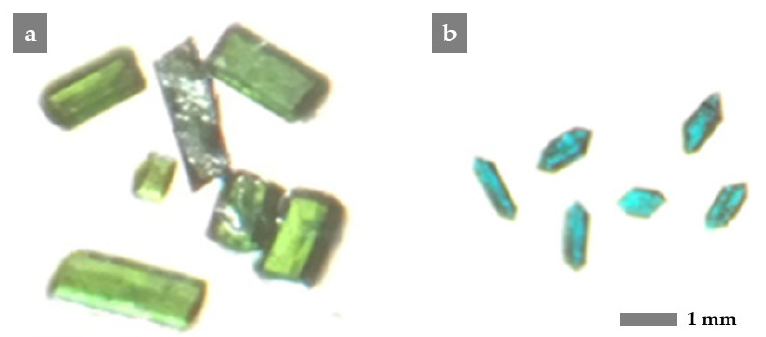
Figure 1. The obtained single crystal photos for 1 ( a ) and 2 ( b ).